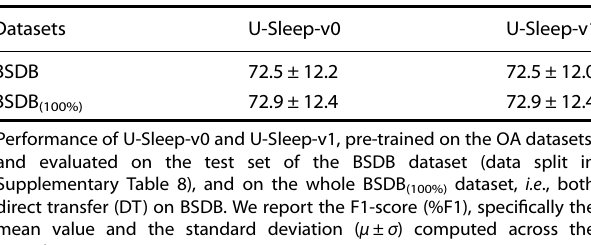
mean value and the standard deviation ( μ ± σ ) computed across the